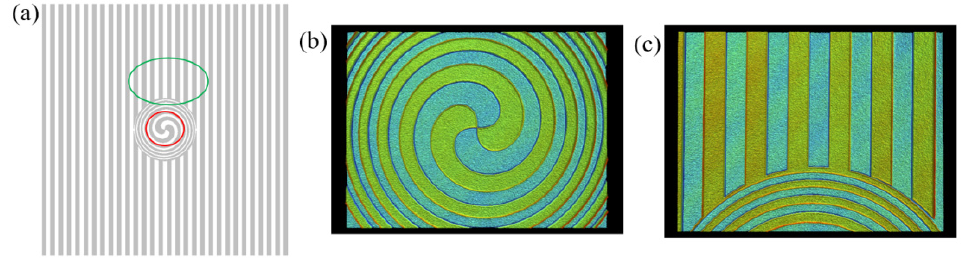
Figure 11. ( a ) Simulation design of the CSZPG with TC = 2, ( b ) fabricated CSZPG from the selected red circle in the simulation design shown in ( a , c ) fabricated CSZPG from the selected blue circle in the simulation design shown in ( a ).